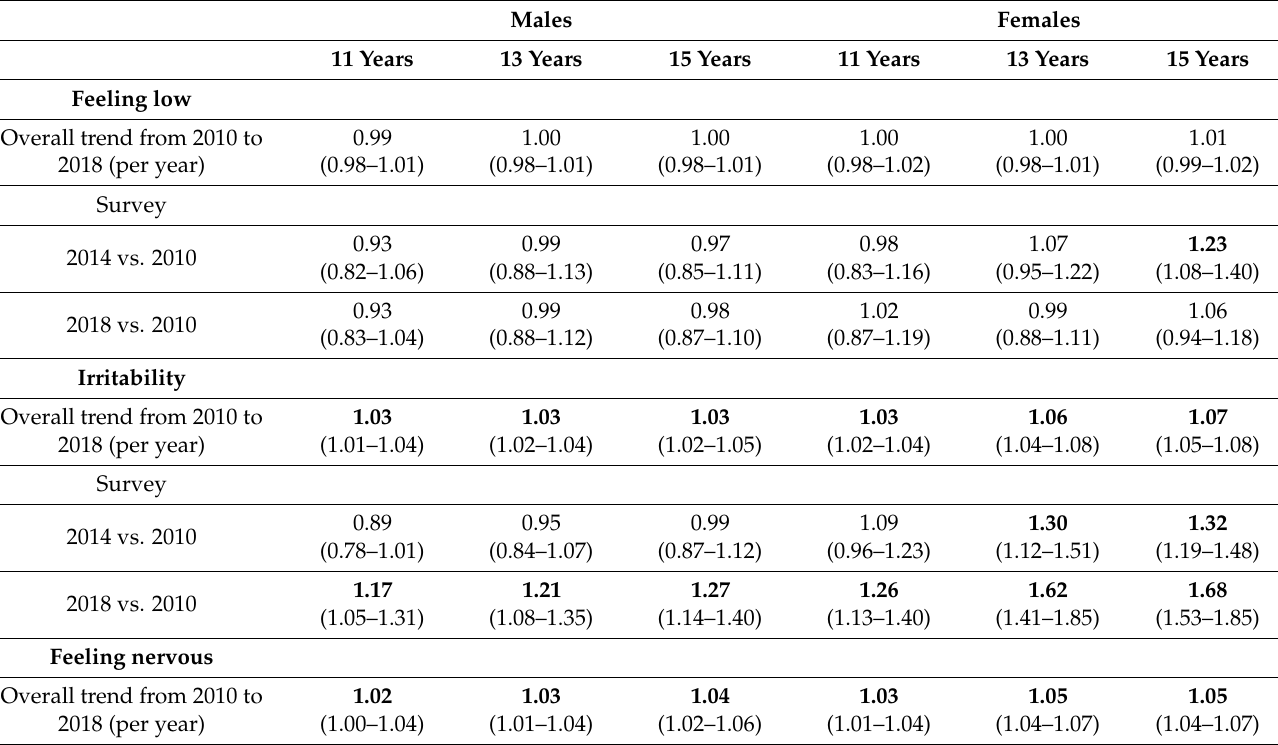
Table A3. Multivariable logistic regression (OR (95%CI)) predicting feeling low, irritability, feeling nervous and sleeping difficulty (PSY-HC), stratified by gender and age groups. Males